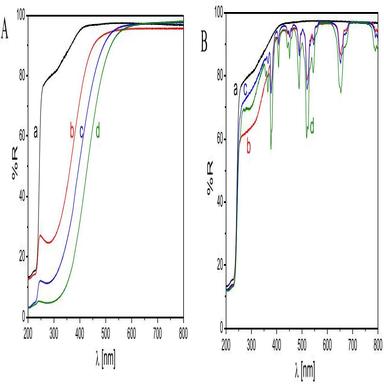
Diffuse reflectance absorbance spectra of pure ZrO2 (a, black) and REO-doped ZrO2 (panel A: REO ¼ CeO2, panel B: REO ¼ Er2O3) with increasing concentration of REO dopant: 0.5%mol (b, red), 1%mol (c, blue), 5%mol (d, green). (For interpretation of the references to color in this figure legend, the reader is referred to the Web version of this article.)